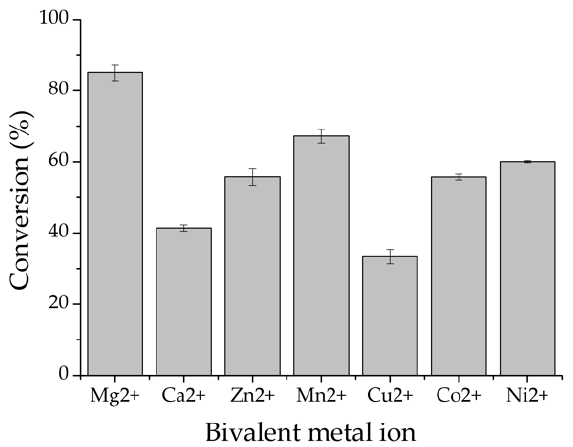
Figure 9. Optimization of bivalent metal ions in terms of conversion efficiency with polyphosphate- dependent mannose kinase, mannose (20 g/L) and (NaPO 3 ) 6 (60 g/L) at 30 °C at pH 8.5. The best effects were found with Mg 2+ , which is cost-effective and suitable for industrial applications.